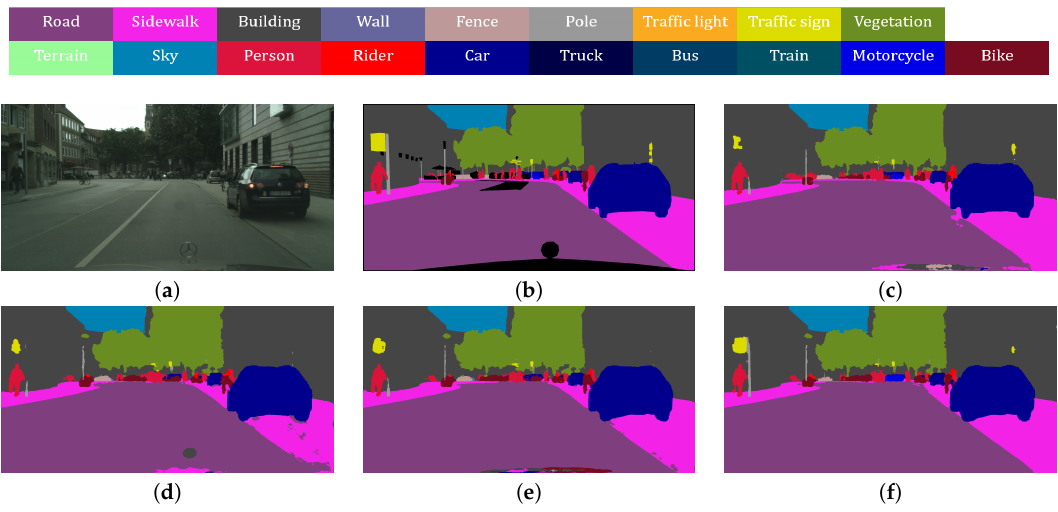
Figure 1. Comparison of the proposed distillation method and other methods. ( a ) Input image. ( b ) Ground truth. ( c ) Result of the teacher network. ( d ) Result of the student network without distillation. ( e ) Result of the student network using Pair-wise distillation [28]. ( f ) Result of the student network using the proposed distillation